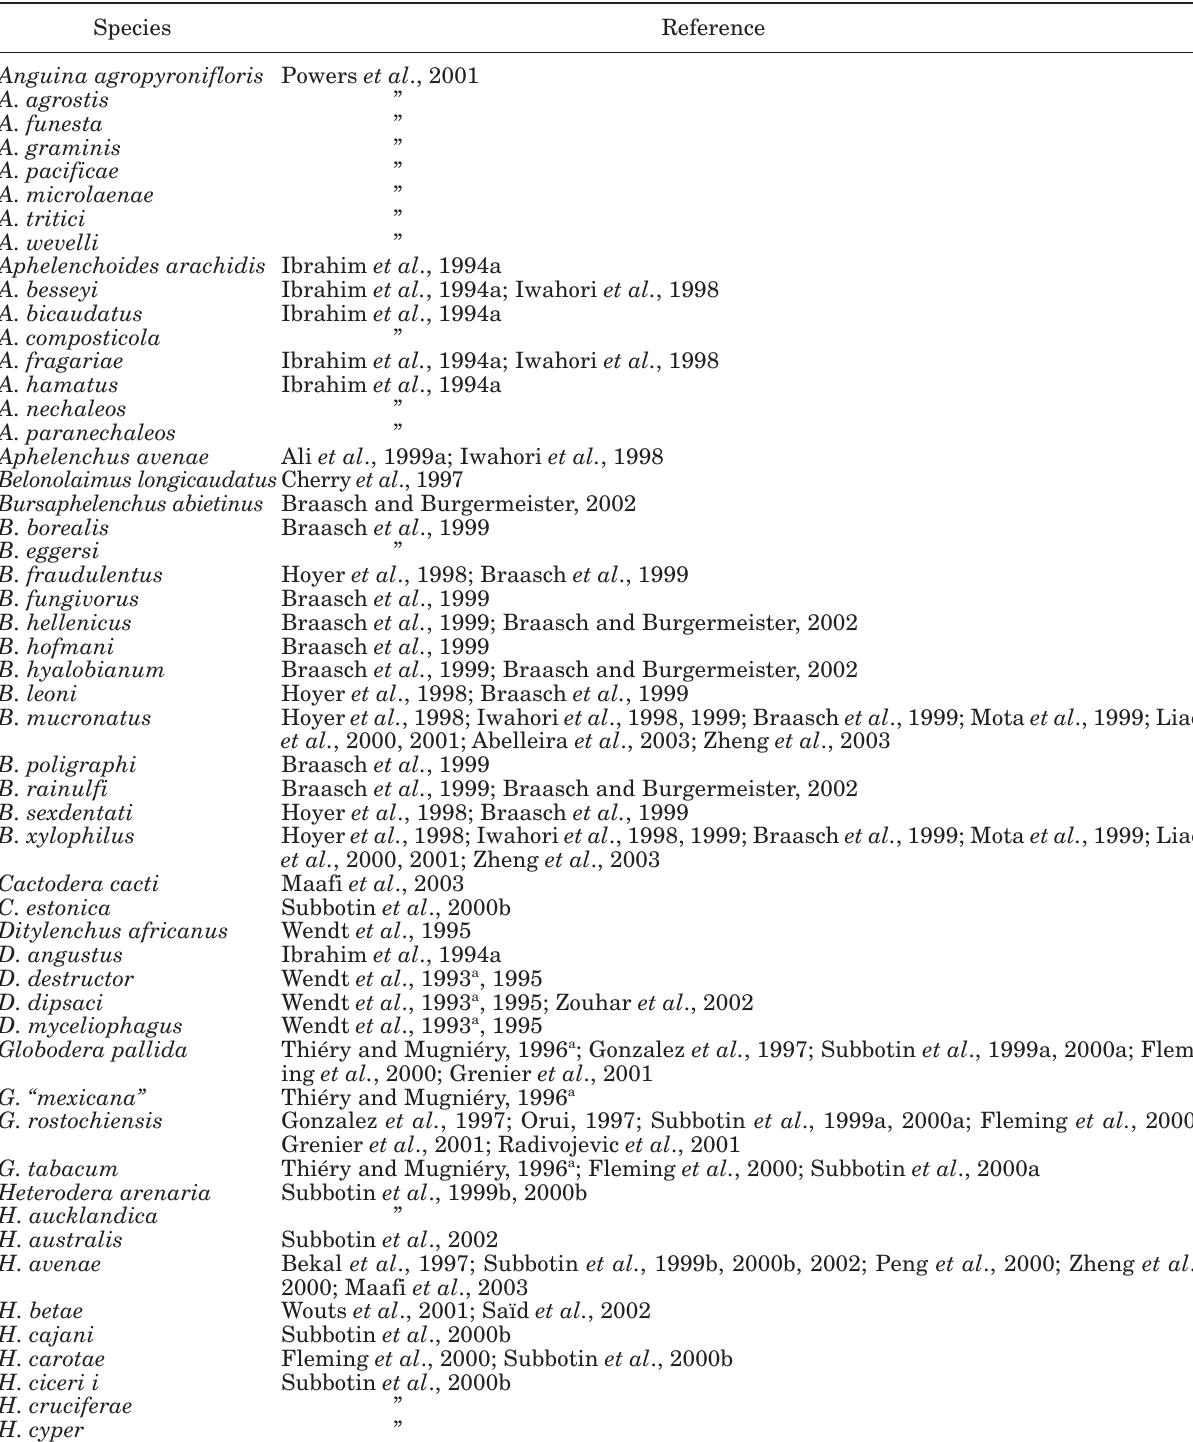
Table 8. Plant-parasitic nematodes characterized by PCR-RFLP of ITS